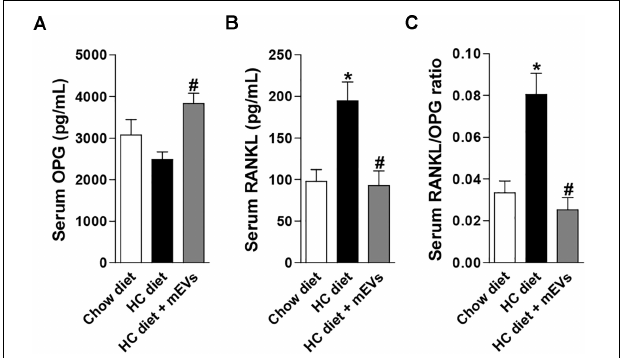
FIGURE 2 | Evaluation of the RANKL/OPG system in the serum of mice fed with high refined carbohydrate-containing (HC) diet and treated with milk extracellular vesicles (mEVs). Serum levels of (A) osteoprotegerin (OPG), (B) receptor activator of nuclear factor κ B ligand (RANKL), and (C) RANKL/OPG ratio. Analyses were performed in mice that received (i) a standard diet (Chow diet), (ii) a HC diet, or (iii) HC diet treated with mEVs (HC + mEVs). Values are means ± SEM of 6–7 animals per group. * vs. Chow diet and # vs. HC diet group, P <